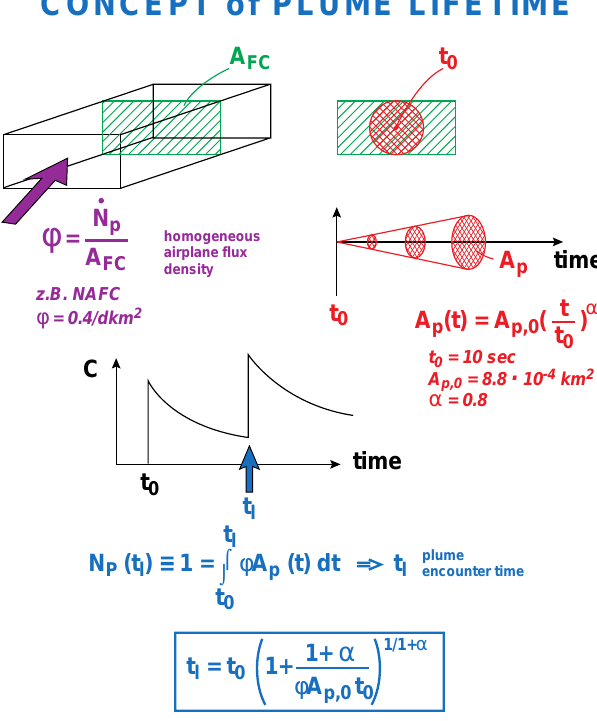
Fig. 7. Schematic description of average plume encounter time, t l of a single aircraft in a flight corridor (Meilinger et al., 2005).